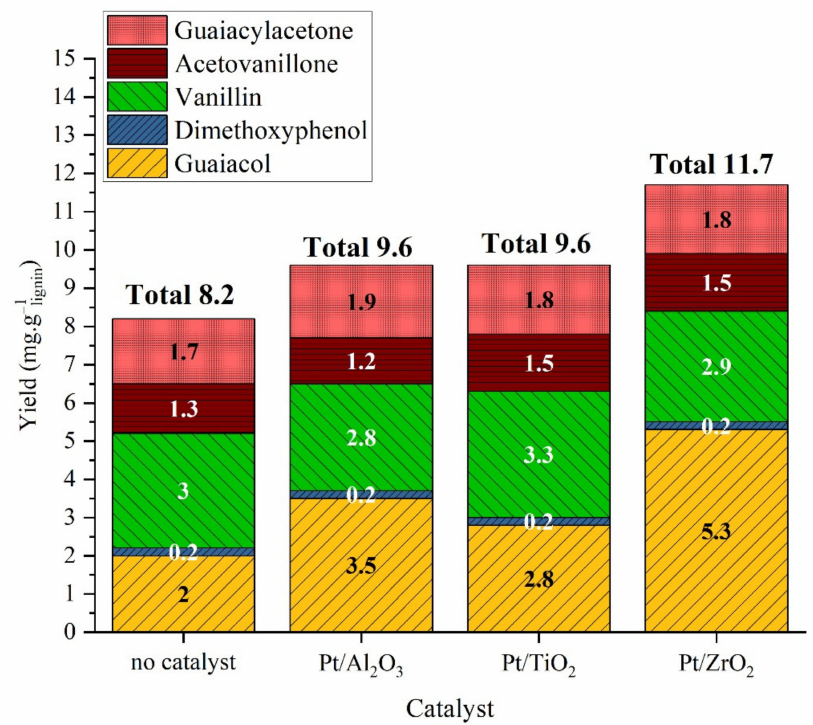
Figure 5. Yield of monomeric products in organic phase after lignin catalytic liquefaction over platinum catalysts. Reaction conditions: Kraft lignin 10 g · L − 1 , 3 h, 225 ◦ C, 40 bar